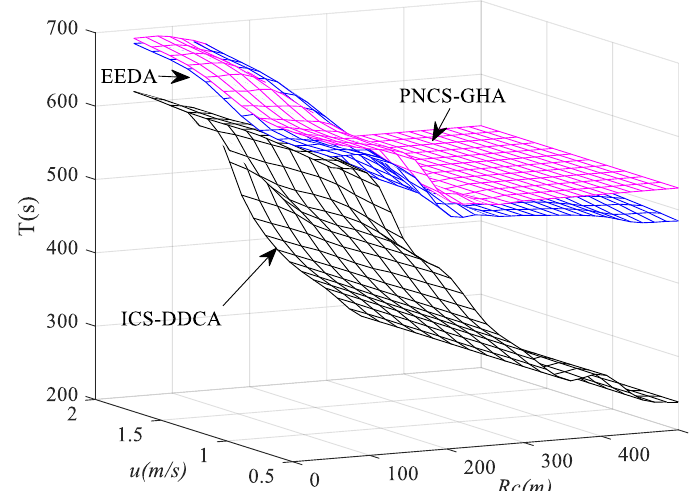
Fig. 9 Influence of node mobility and